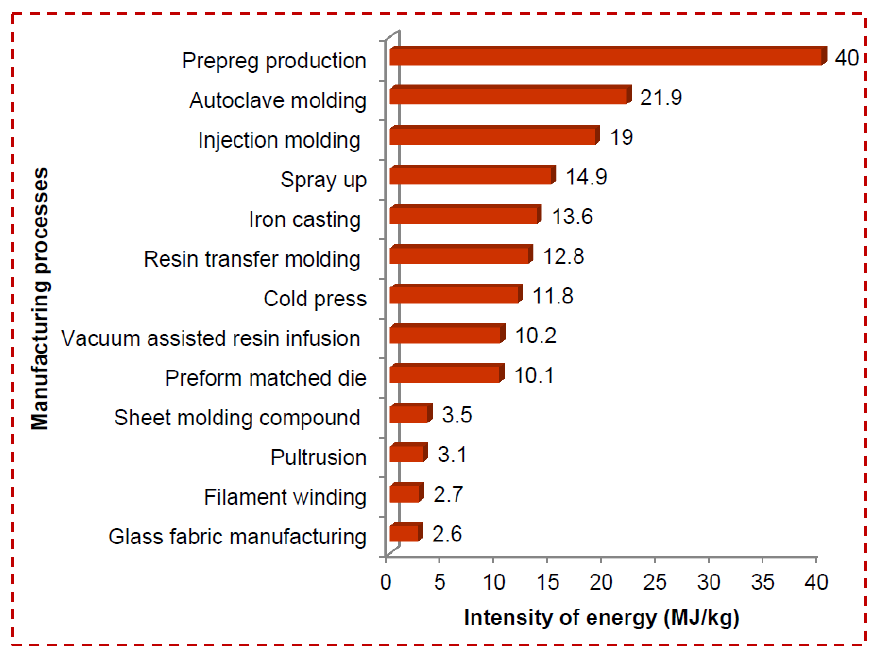
Figure 16. Energy intensity of composite manufacturing techniques [147].